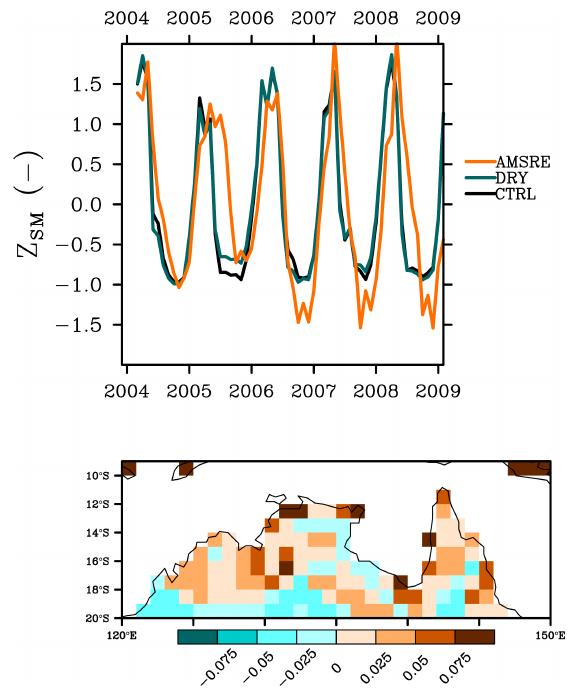
Figure 2. (a) The mean normalized (using the first two moments) first layer soil moisture (SM 1 ) from the CTRL and DRY simula- tions and the AMSR-E observations. (b) The difference between the mean SM 1 (from all simulations over all months from 2004 to 2009) and the AMSR-E